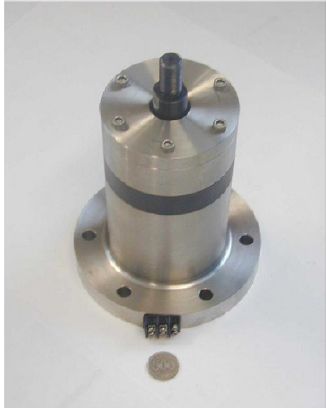
Figure 2. Linear magnetostrictive actuator prototype developed in [75]. Reprinted with permission from